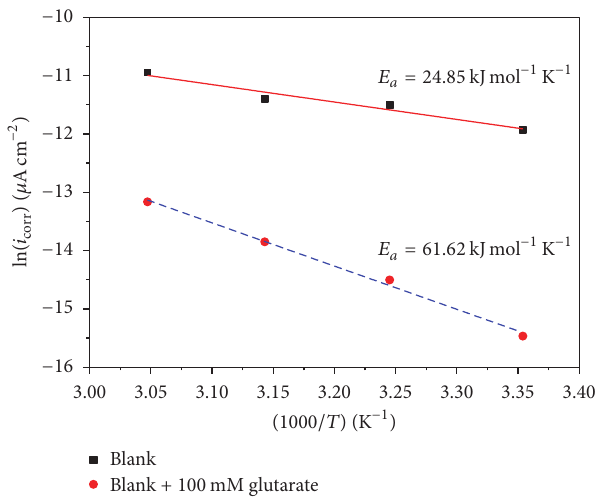
Figure 7: Arrhenius plot of the corrosion of carbon steel in 0.02 M NaCl solution in the absence and in the presence of 100mM glutarate.